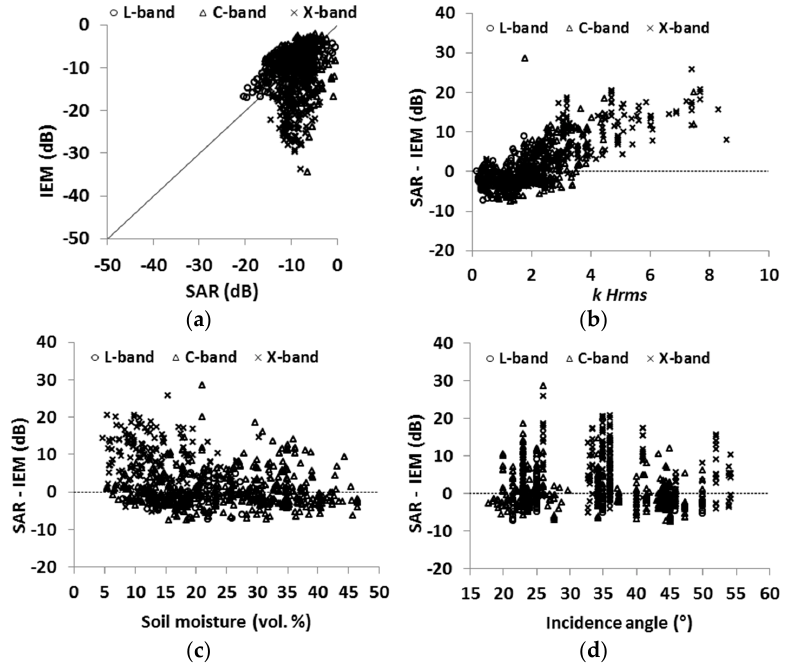
Figure 10. Comparison between backscattering coefficients derived from SAR images and those estimated from IEM at VV polarization using ECF. ( a ) IEM simulations vs. SAR data; ( b ) difference between SAR signal and IEM vs. soil roughness ( kHrms ); ( c ) difference between SAR signal and IEM vs. soil moisture ( mv ); ( d ) difference between SAR signal and IEM vs. incidence angle.